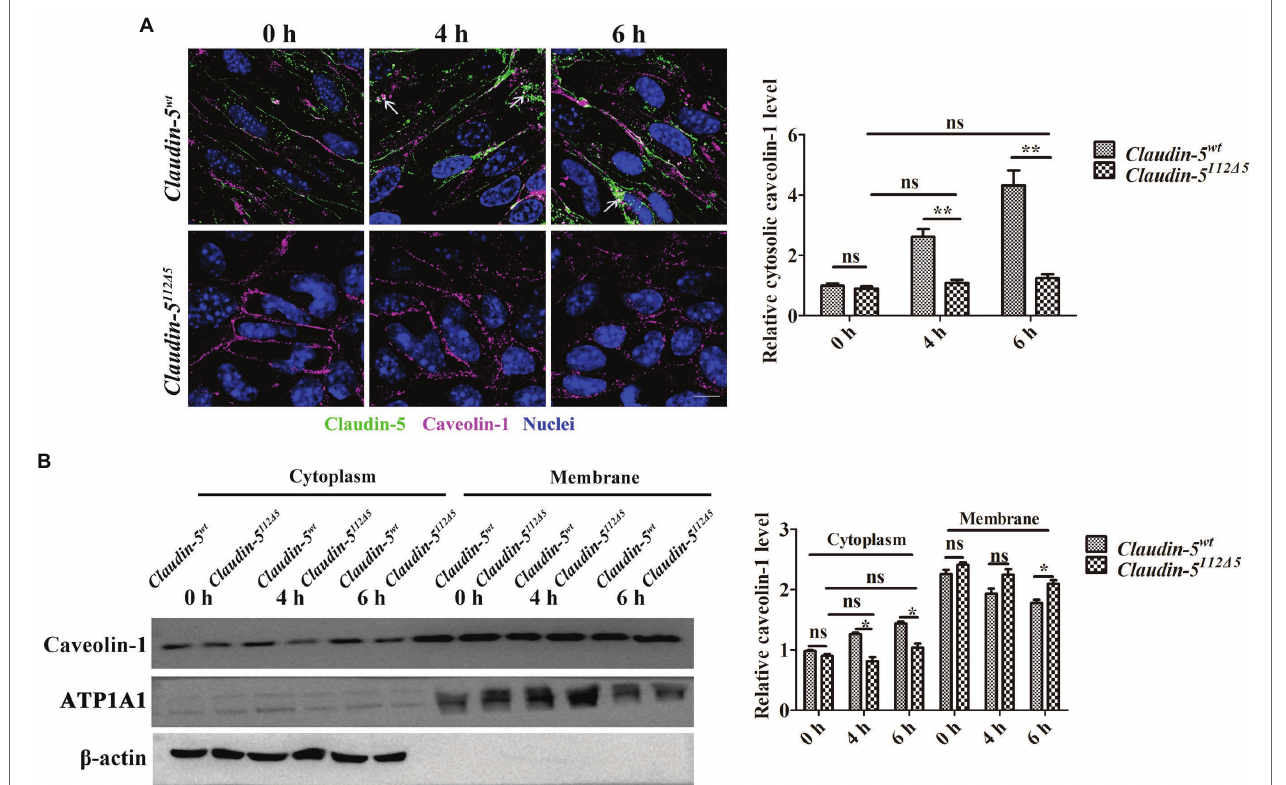
FIGURE 3 | Caveolin-1 (Cav-1)-mediated Claudin-5 redistribution in response to hypoxia. (A) Confocal microscopy images of Claudin-5 (green) and Cav-1 (purple). Colocalization of Claudin-5 and Cav-1 (white arrows). Mean ± SD, n = 3 independent experiments per group. Scale bar, 10 μ m. (B) Western blot analysis of Cav-1 in the cytoplasm and membrane. Mean ± SD, n = 3 independent experiments per group. * p < 0.05 and ** p <